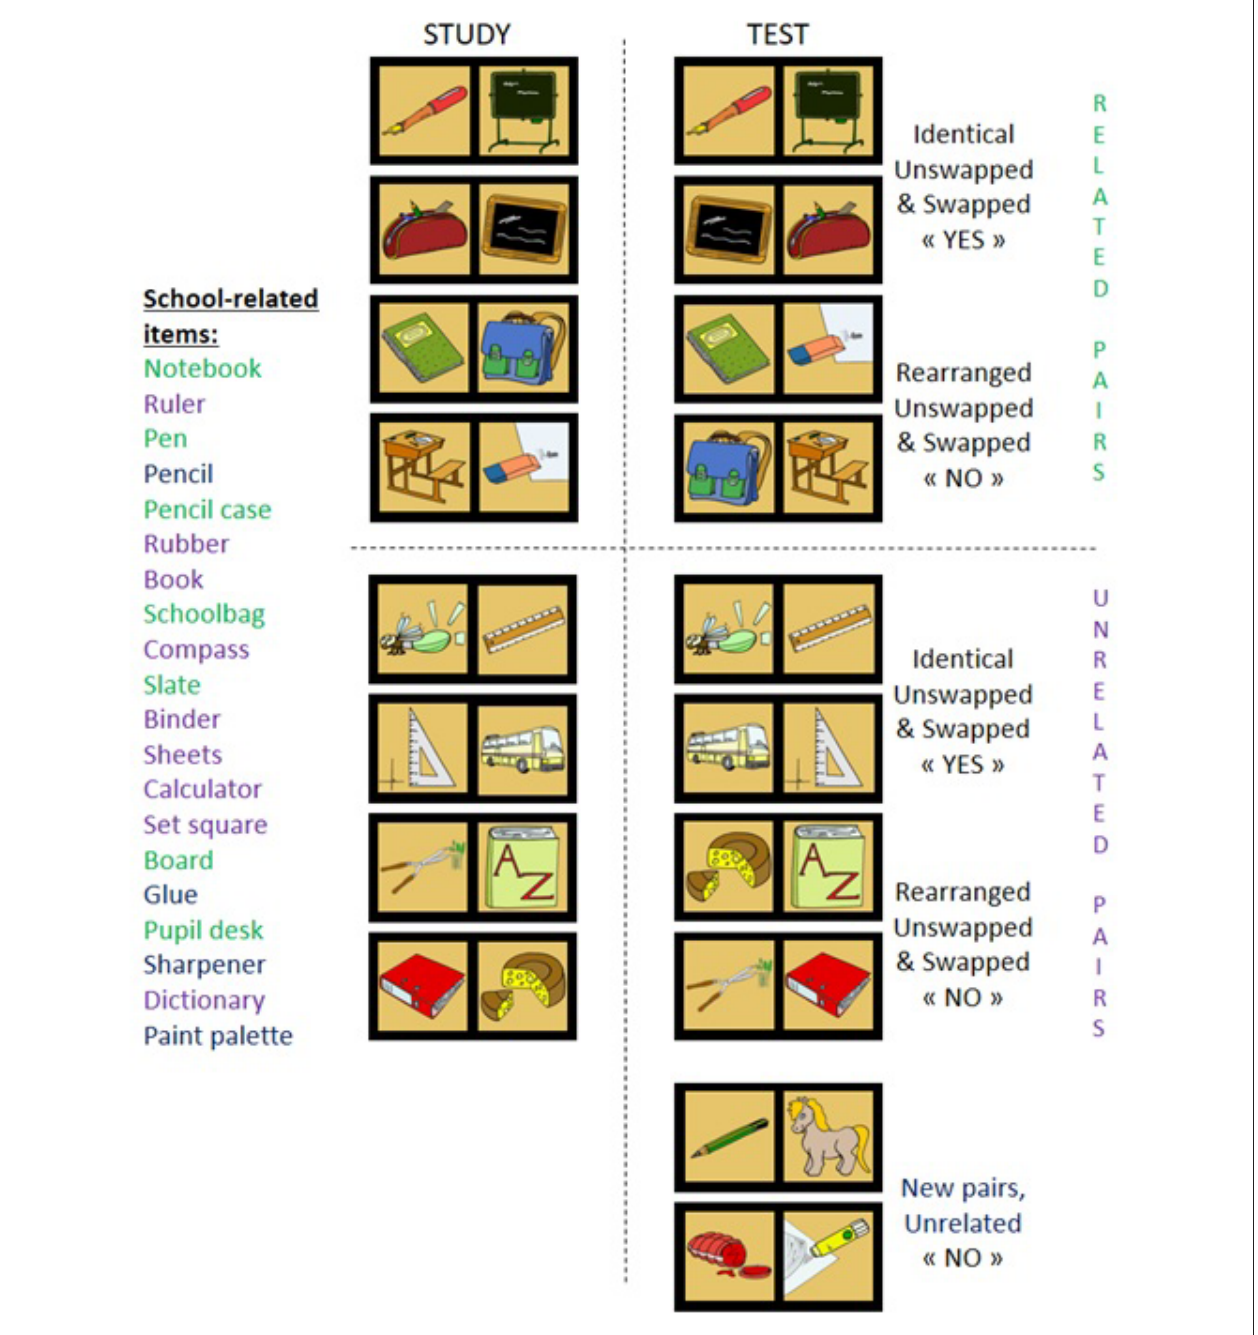
FIGURE 1 | Each of 20 semantic categories contains 20 pictures (e.g., furniture on the left). At study phase, eight items (green) are paired to create strongly related pairs, eight others (purple) are intermixed with items from other categories to create unrelated pairs, while the remaining four (blue) are intermixed with items from other categories and used to create new pairs presented only at test. For the test phase, half of strongly related pairs used at study remained similar (identical related pairs), while other half was rearranged (rearranged related pairs). The same applies to unrelated pairs. Positions of items within a pair were swapped for half identical and rearranged